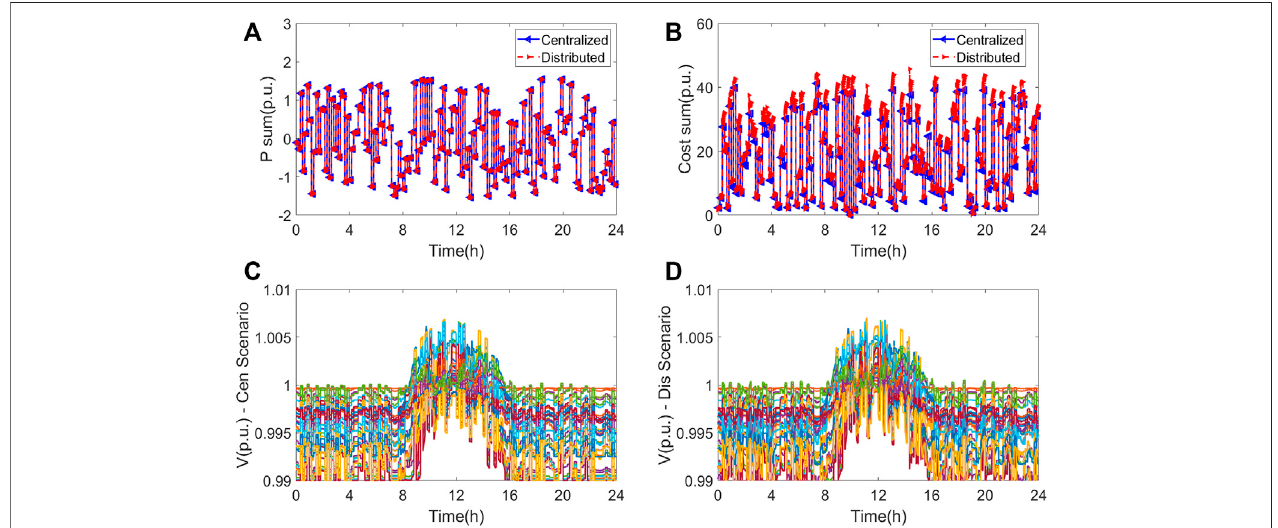
FIGURE 8 | Case III: comparative results of VSP dispatch using a centralized optimization and the proposed distributed control: (A,B) active power outputs of individual storage devices; and (C,D) reactive power outputs of individual storage devices.